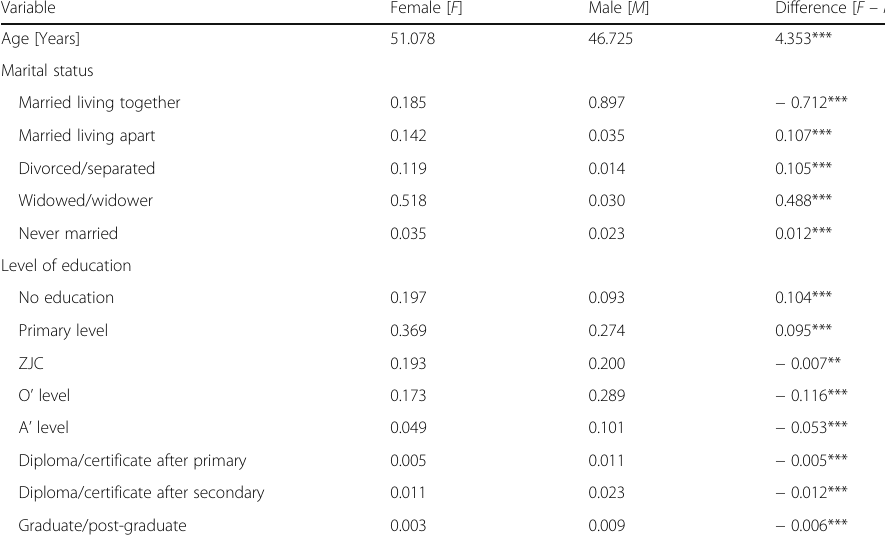
Table 2 Background characteristics of the household heads by gender